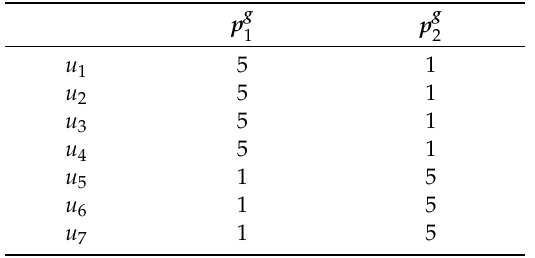
Table 2. The user-item rating matrix after a clustering of